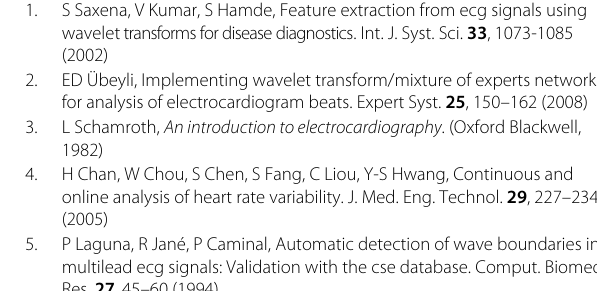
The proposed method obtains a high averaged detection accuracy, sensitivity, and positive predictivity of 99.43, 99.69, and 99.72%, respectively. Although the existence of various normal and abnormal QRS complex wave-